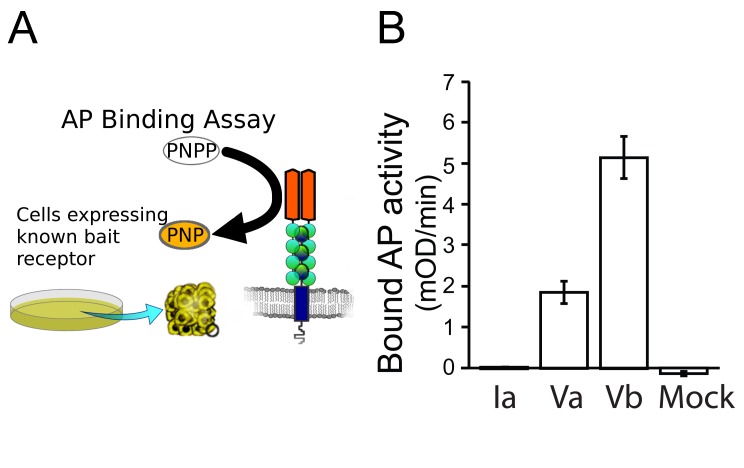
The Side-VI ectodomain binds to Beat-Va and Beat-Vb expressed on the surfaces of S2 cells.(A) Graphical representation of the AP binding assay. AP supernatant (0.5 nM) is incubated with cells expressing a receptor on their surface and bound AP activity is detected after washing. (B) Beat-Va and Beat-Vb expressed on Drosophila S2 cells bind soluble Side-VI-AP (p<0.005; N = 3), but Beat-Ia does not.